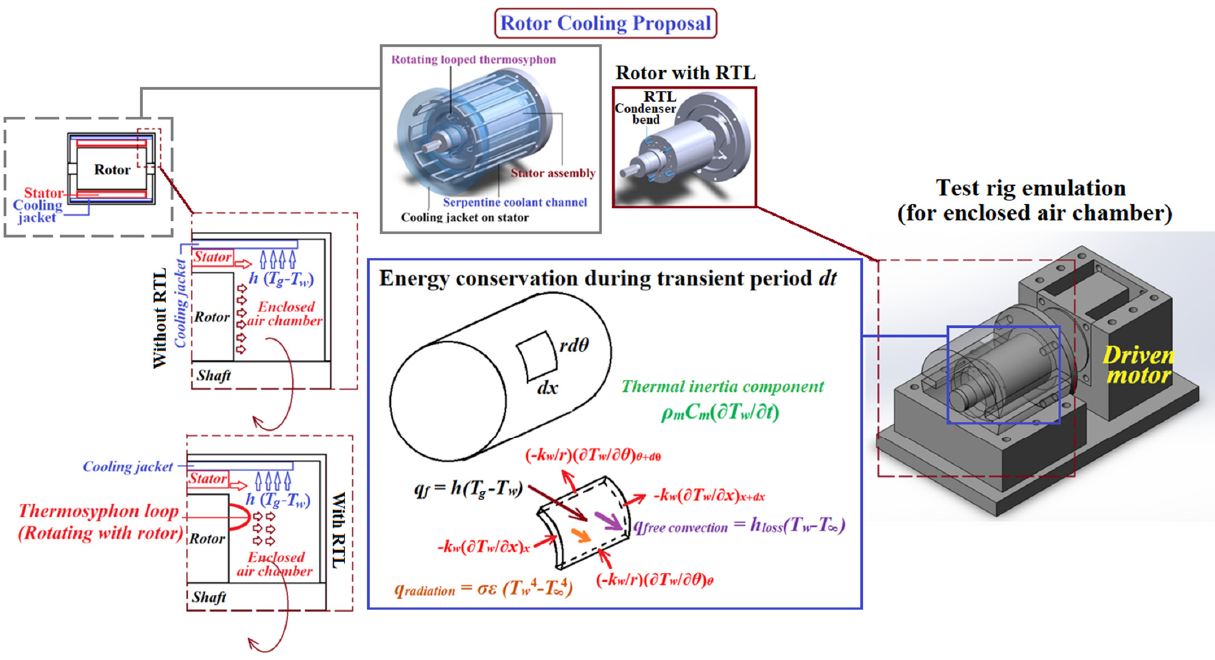
Figure 4. Energy conservation scenario of a small element dxrd θ taken from the stainless-steel foil confined within the slotted window during the transient period δ t .